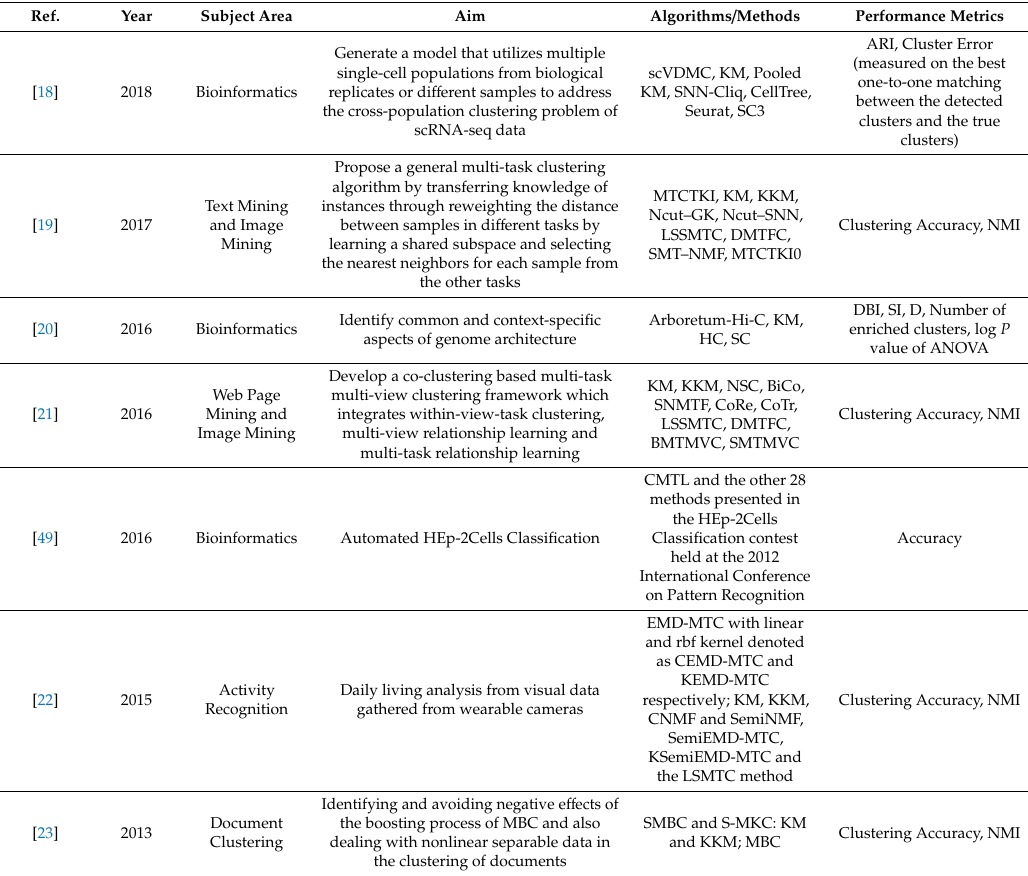
Table 2. Summary of the data mining studies taking “Multi-Task Clustering” as the main subject.